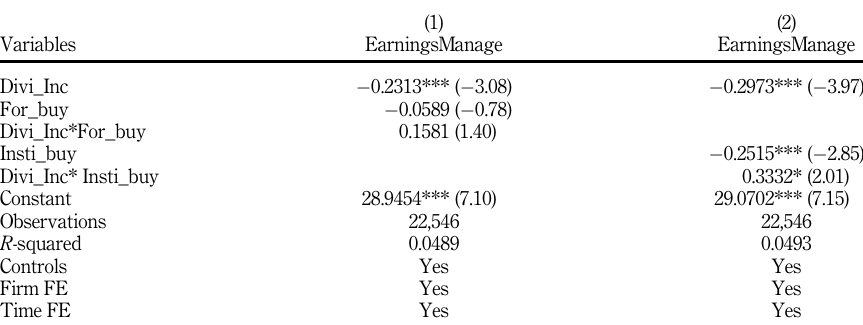
Table 7. With the change in ownership level of foreign and domestic institutional